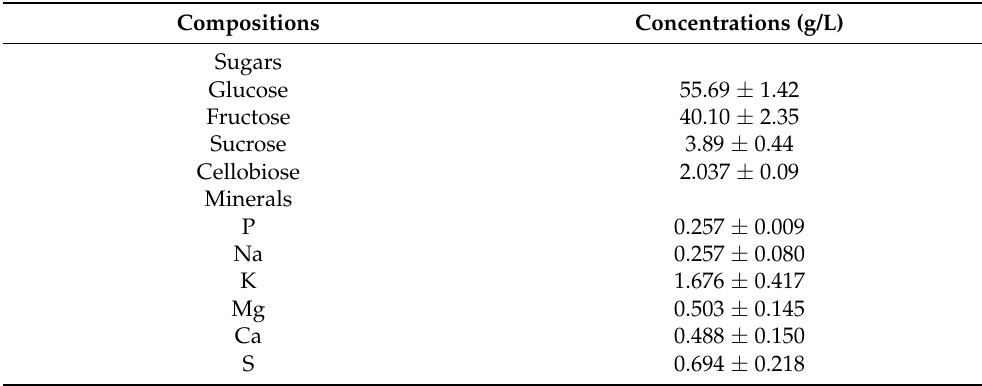
Table 1. Chemical characteristics of OPT